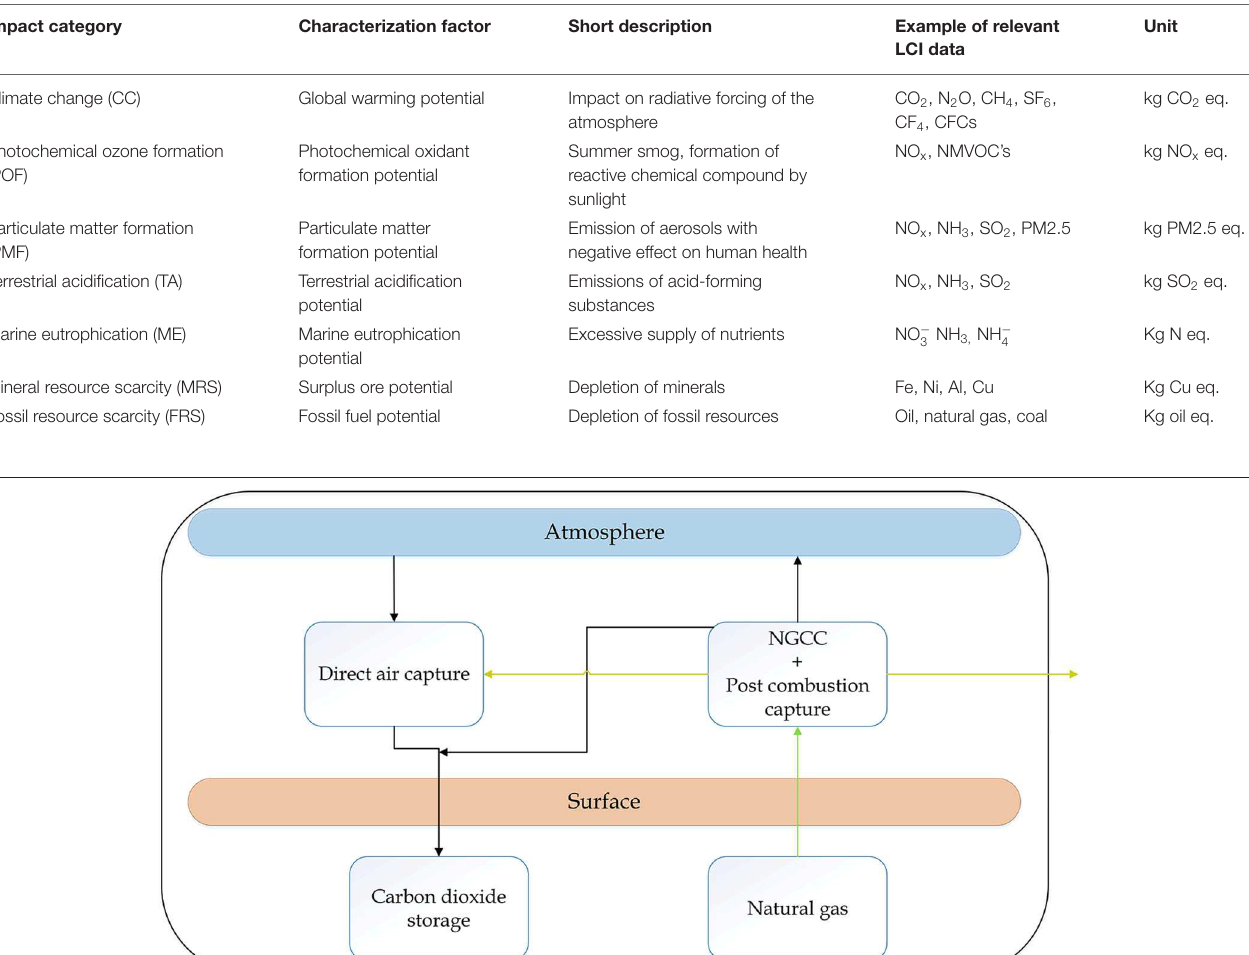
TABLE 1 | Impact categories included in this LCA.